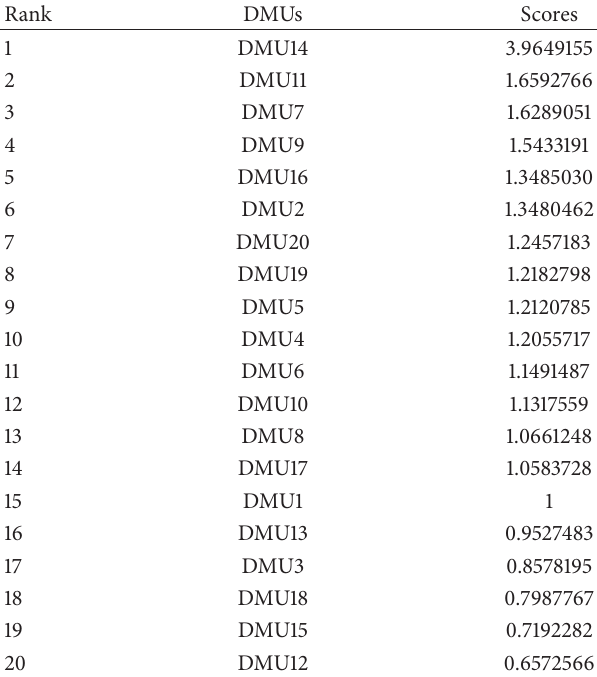
Table 11: Efficiency and ranking before strategic alliances. Table 12: Efficiency and ranking after strategic